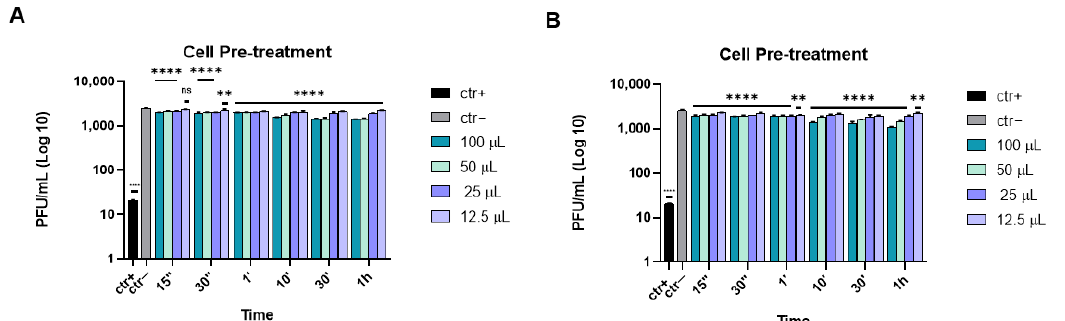
Figure 3. Cell pre-treatment assay of the antiviral activity of ophthalmic solutions against HSV-1 at different times of incubation. Iodim ( A ) and Ozodrop ( B ) were first incubated on the cell monolayer prior to infection. Dextran-sulphate [35] was used as a positive control (ctr+). Data are means of three independent experiments. Statistical analyses were determined by two-way ANOVA, followed by a Bonferroni postdhoc test. Significance refers to the negative control (ctr–), i.e., the infected cells. ** p < 0.001; **** p < 0.0001; ns: non-significant.